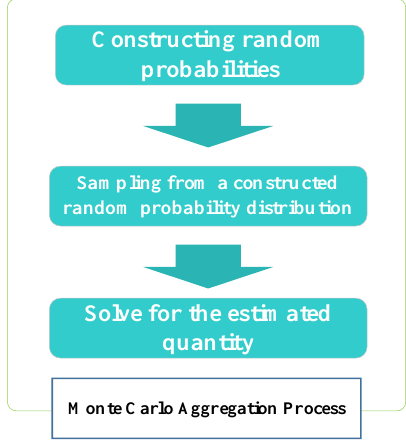
Figure 3. Monte Carlo aggregation process.